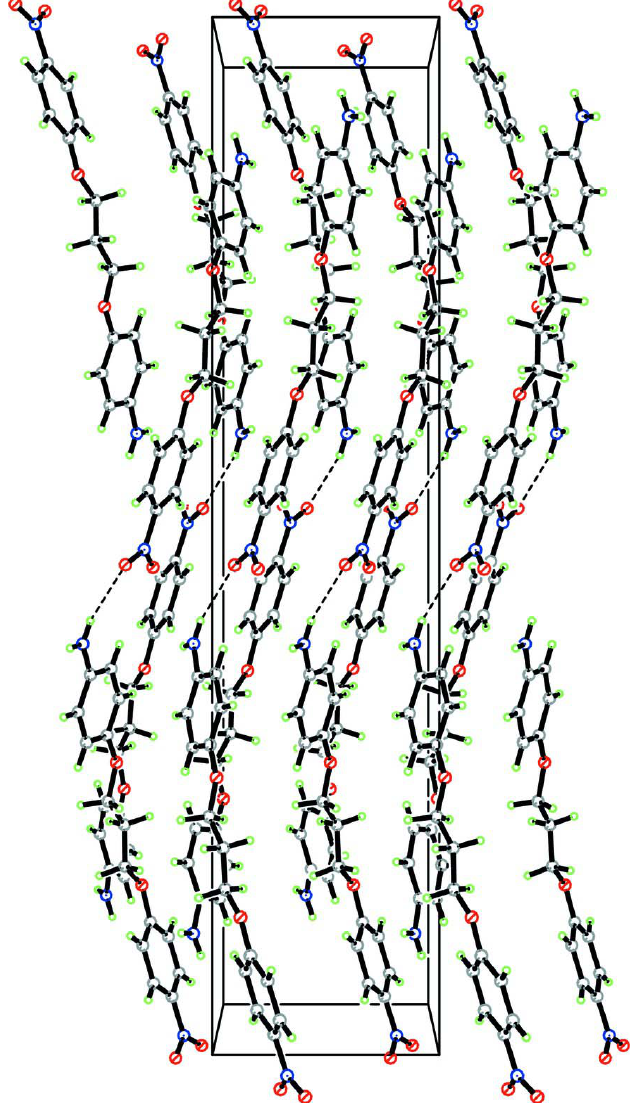
Packing diagram of (I). Hydrogen bonds are shown as dashed lines.